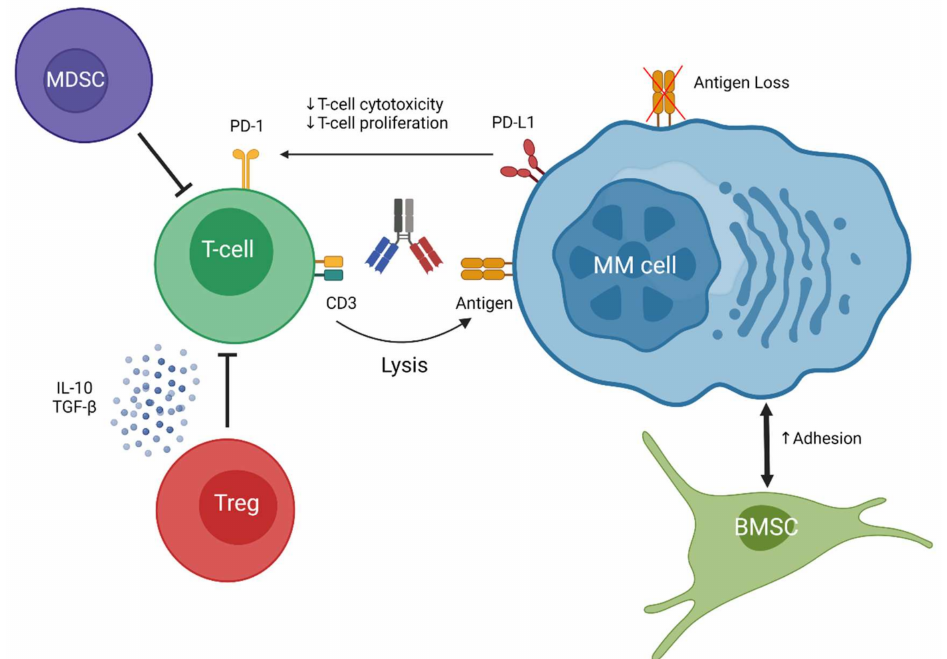
Figure 2. A schematic overview of different resistance mechanisms that impair BsAb-induced T cell-mediated lysis of MM cells. BMSC = Bone marrow stromal cell; MDSC = Myeloid-derived suppressor cell; MM cell = Multiple myeloma cell; Treg = regulatory T